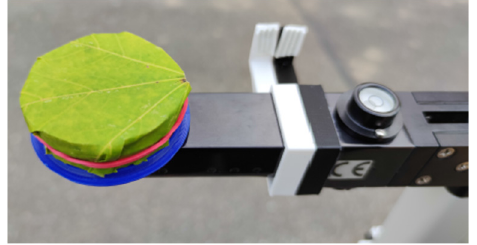
Figure 9. Photo of the setup to measure the transmittance of a single leaf of the Norway maple